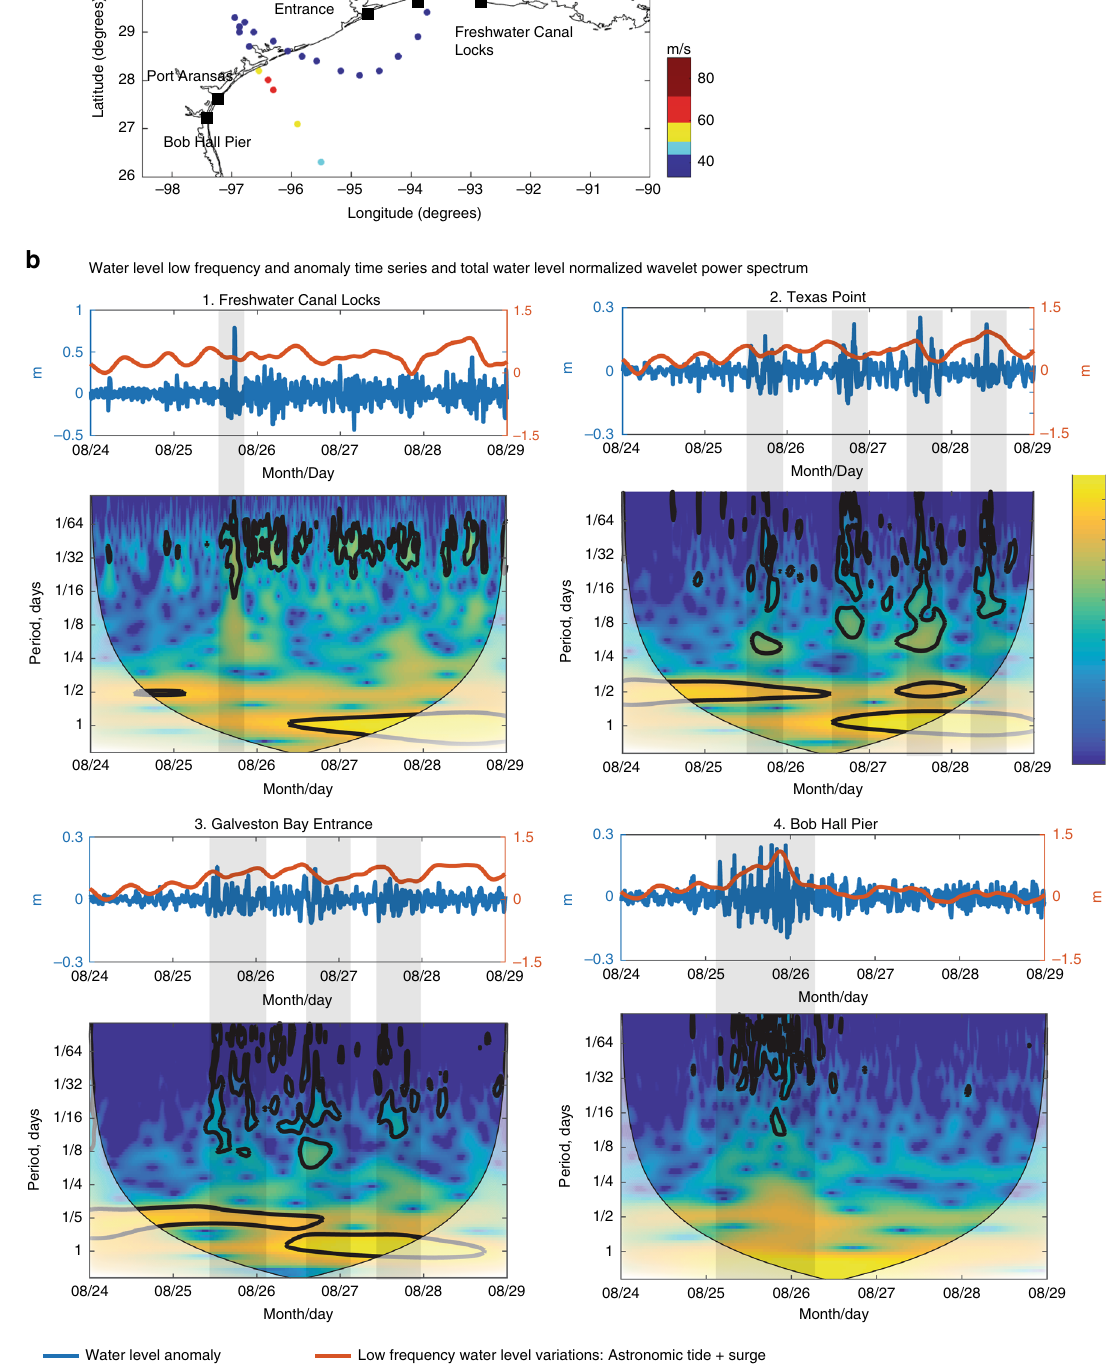
Fig. 2 Water levels during Harvey (2017). Water level anomaly time-series and normalized wavelet power spectrum during Harvey (2017). a Locations of the considered tide gauges (squares), the best-track (dots), and maximum sustained wind speeds (dot color) of Harvey (2017); b Water level time- series and total water level normalized wavelet power spectrum in the stations most affected by Hurricane Harvey (2017). Water level anomalies are indicated by blue lines and the corresponding y -axis is on the left; variations due to tides and surge are represented by the orange lines and the corresponding y -axis is on the right. The x -axis indicates the time in UTC, Month/Day. The contour lines in the normalized wavelet power spectrum indicate the 95% con fi dence level against red noise. Translucent portions of the diagrams represent data outside the cone of in fl uence. Main meteotsunamis are indicated with gray shading. Note: There is a difference in the scale of the water level anomaly between Freshwater Canal Locks and the rest of the stations